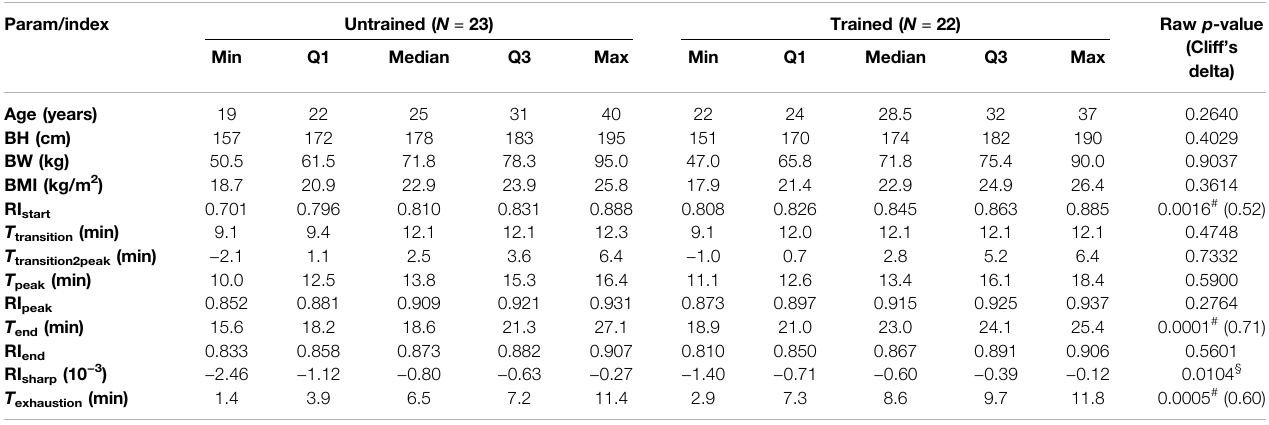
TABLE 2 | Demographic and performance characteristics.